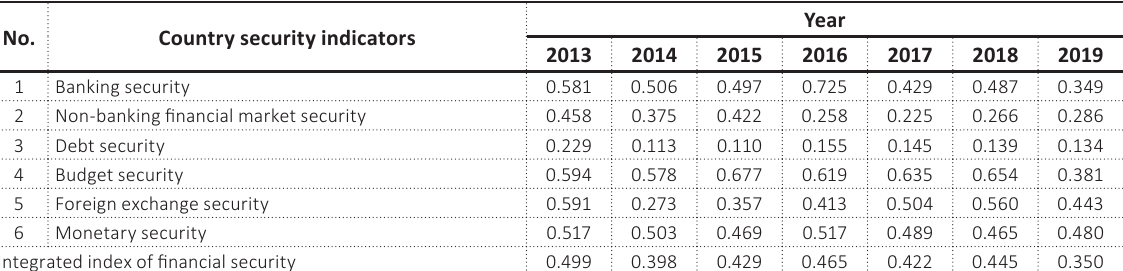
Table 1. Integrated index of the general level of Ukraine’s financial security and its components for 2013–2019